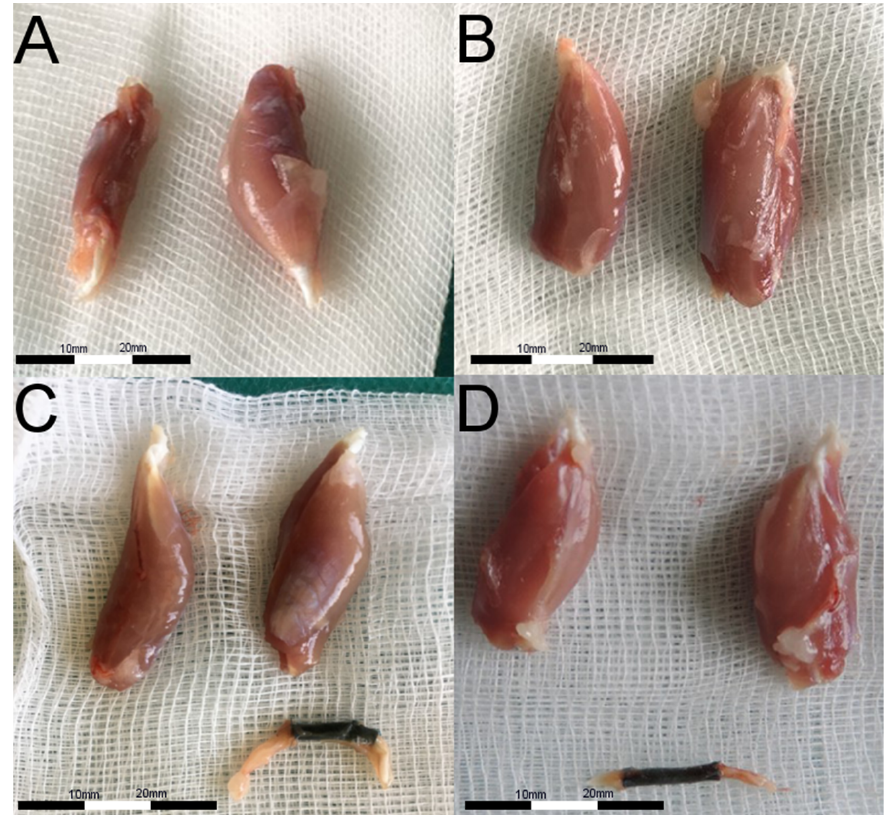
Figure 5. Postoperative images of gastrocnemius muscle excised after 6 months from interventions. On the left side—muscle from an operated limb, on the right side—muscle from the side after reconstructive procedure. ( A ) Control group—nerve gap remained, the muscle was innervated and decreased its size vs. unoperated limb on the right. ( B ) Autograft—muscle size is comparable. ( C ) P(LLA-CL)-COL-PANI conduit integrated into the sciatic nerve (bottom), which substantially preserved gastrocnemius size (left). ( D ) P(LLA-CL)-COL-PANI conduit was enriched with ASC cells, which prevented the muscle from atrophy (left vs. right).